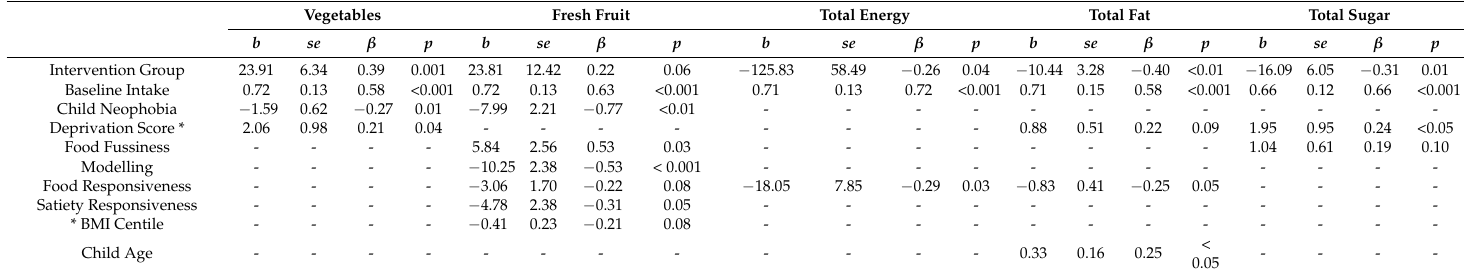
Table 4. Predictors of vegetable intake in week 3: output from a linear